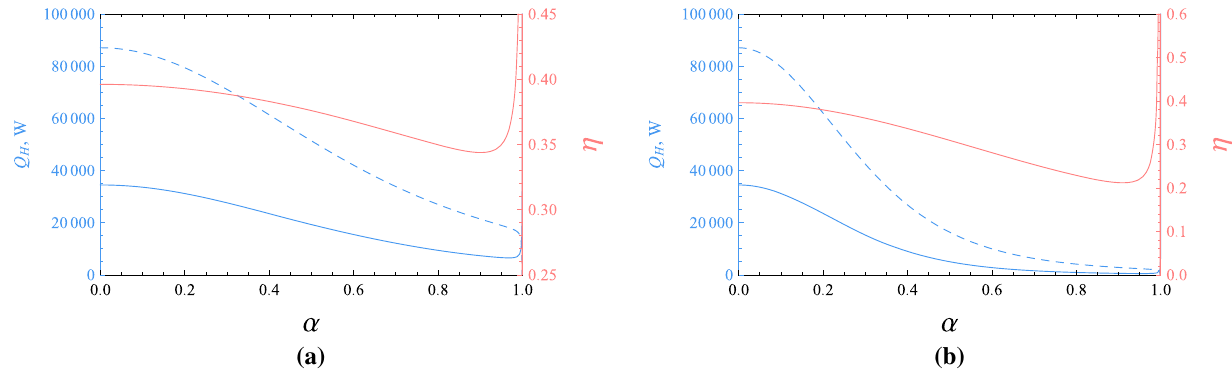
Fig. 10 Total work done ( solid blue curve ) and a net inflow of heat ( dashed blue curve ) for the engine are plotted on left y -axis, efficiency (solid red curve) is plotted on right y -axis for: a Einstein–BI–dilaton theory and b BD–BI theory (see the caption of Fig. 2 for parameter values)